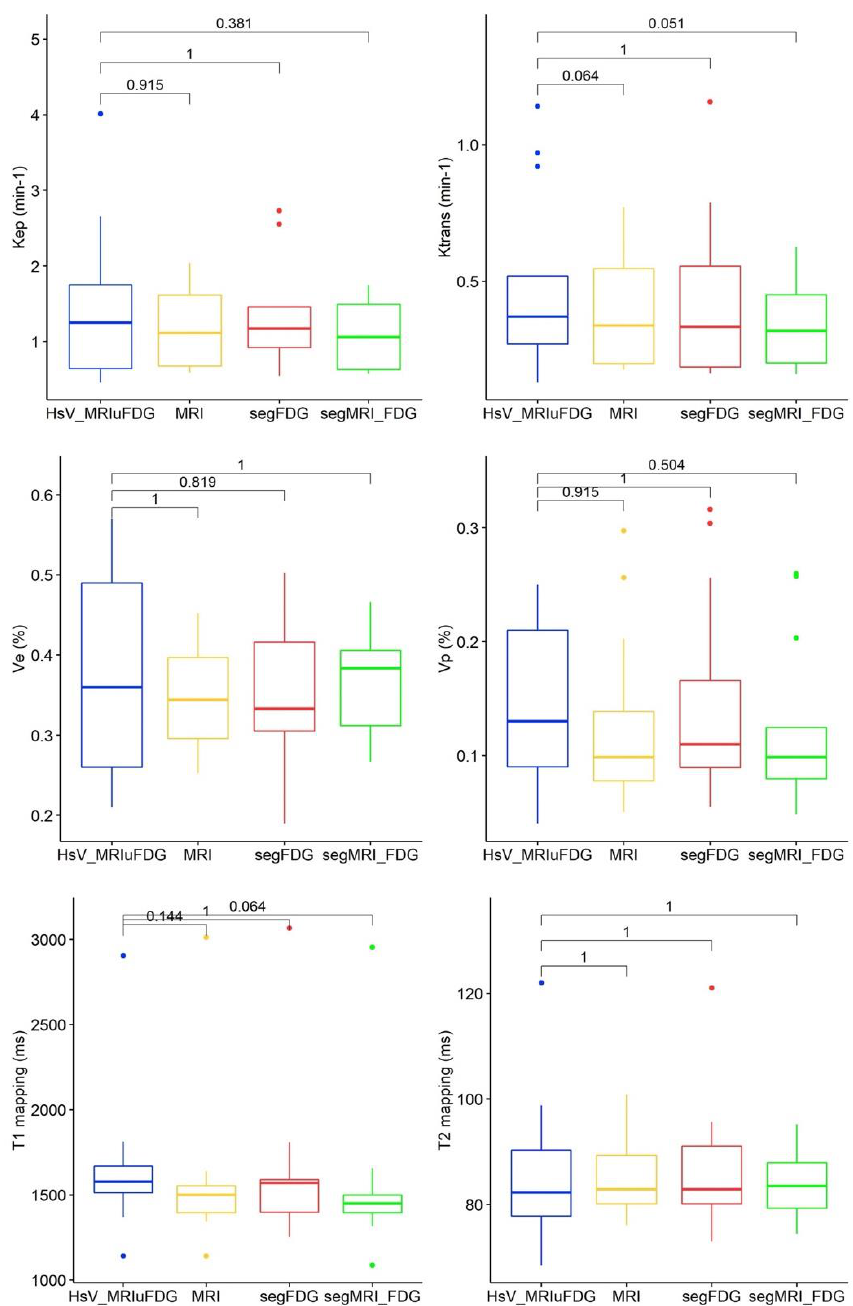
Figure A1. Box plots show evaluation of the difference in each quantitative MRI parameter as a function of tumor volume segmentation method between patients without (red) and with (blue) hypoxic volumes.